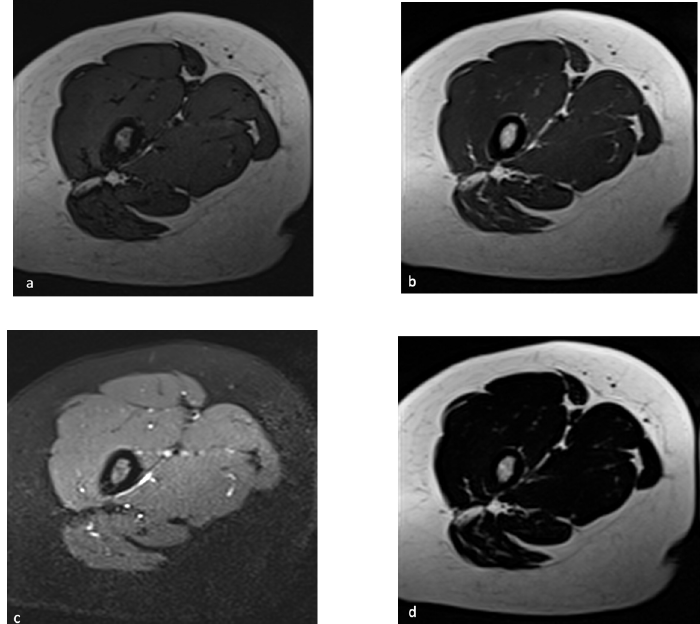
Figure 1. Dixon magnetic resonance sequence acquired on the thigh. Axial T1W out-phase ( a ), in-of-phase ( b ), 100% water images ( c ), and 100% fat images ( d ).